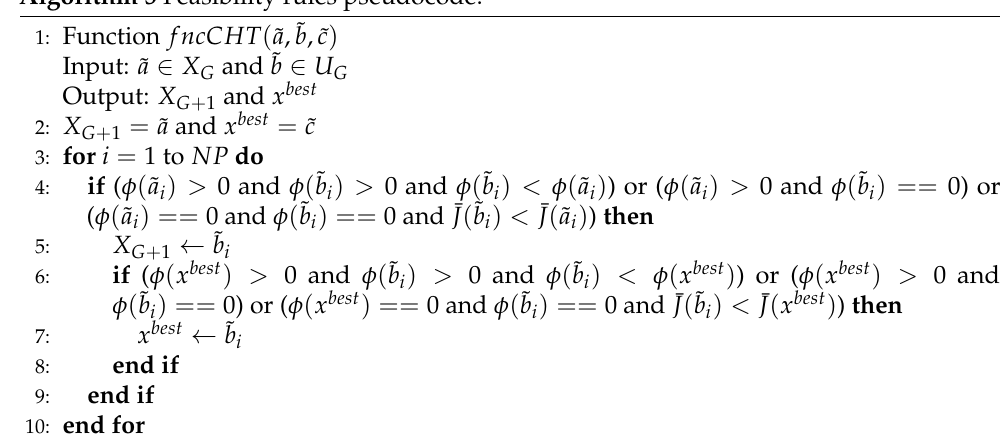
Algorithm 5 Feasibility rules